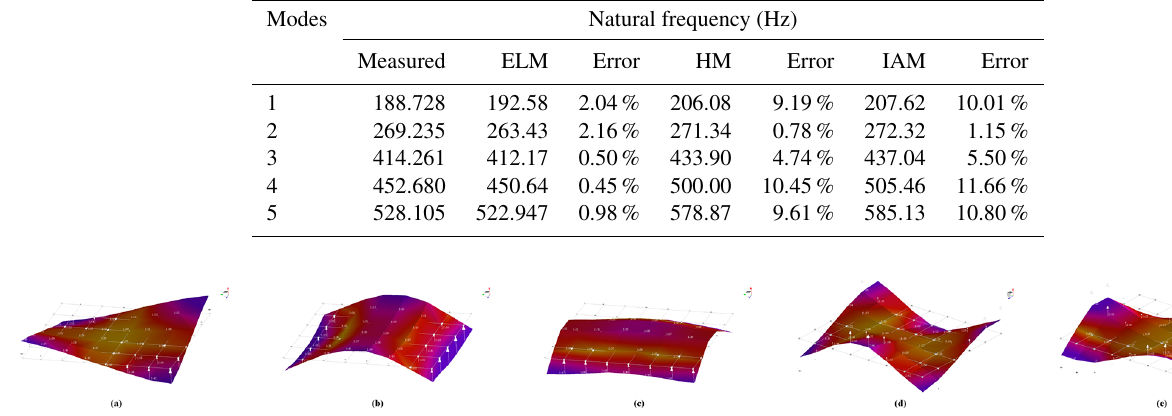
Figure 11. Test results of the first five modes of the honeycomb sandwich panel.